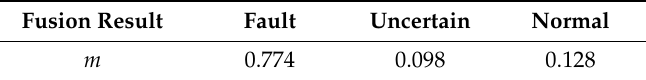
Table 13. The fusion